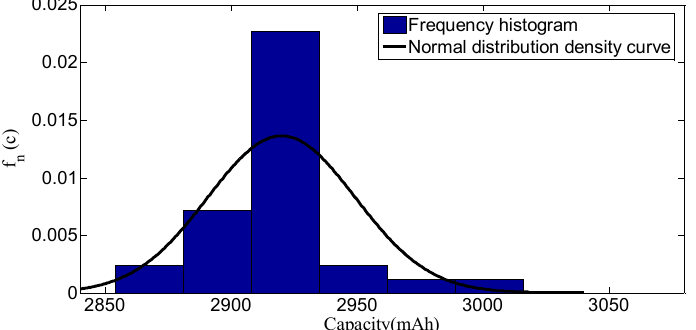
Figure 6. The frequency histogram and theoretical normal distribution density function of the capacity samples after vibration.